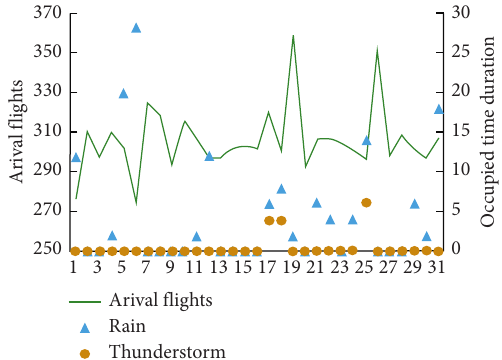
Figure 2: The daily arrival flights and unfavorable weather in May.